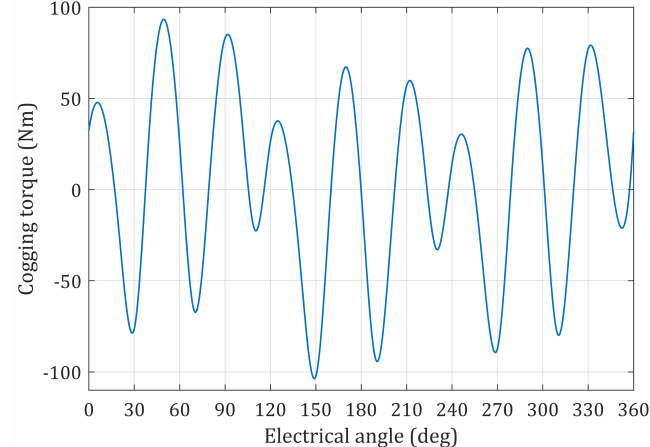
Figure 9. Cogging torque vs. electrical